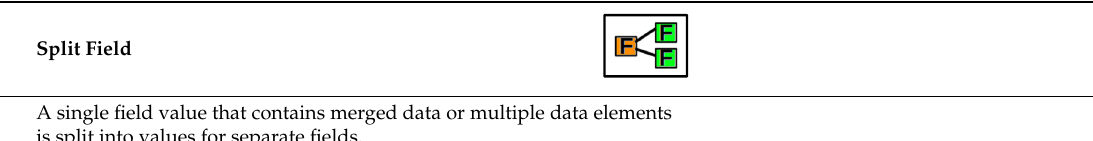
Figure 5. Integration pipeline with three EIPs (Splitter, Translator, and Aggregator).